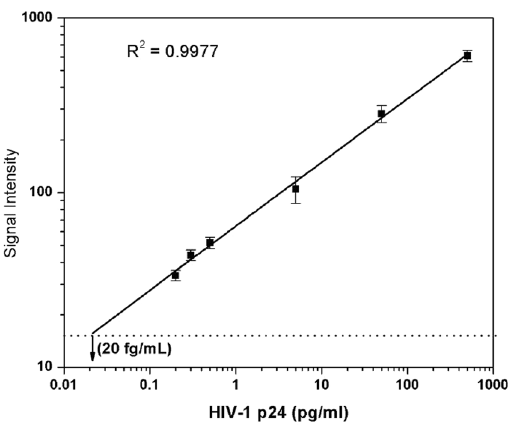
Figure 5. Calibration curve of silica nanoparticle based immunoassay (SNIA) for the detection of HIV-1 p24 antigen (n = 3). Purified HIV-1 p24 antigen (range, 0.02 pg/mL to 1000 pg/mL in serial dilution in PBS) served as target. The normalized relative signal intensities are represented as the ratios of samples over the cutoff value of the negative control. The dotted line (---) represents the cutoff value of negative control. The error bars represent the standard deviation of at least three independent repeated experiments for each assay.